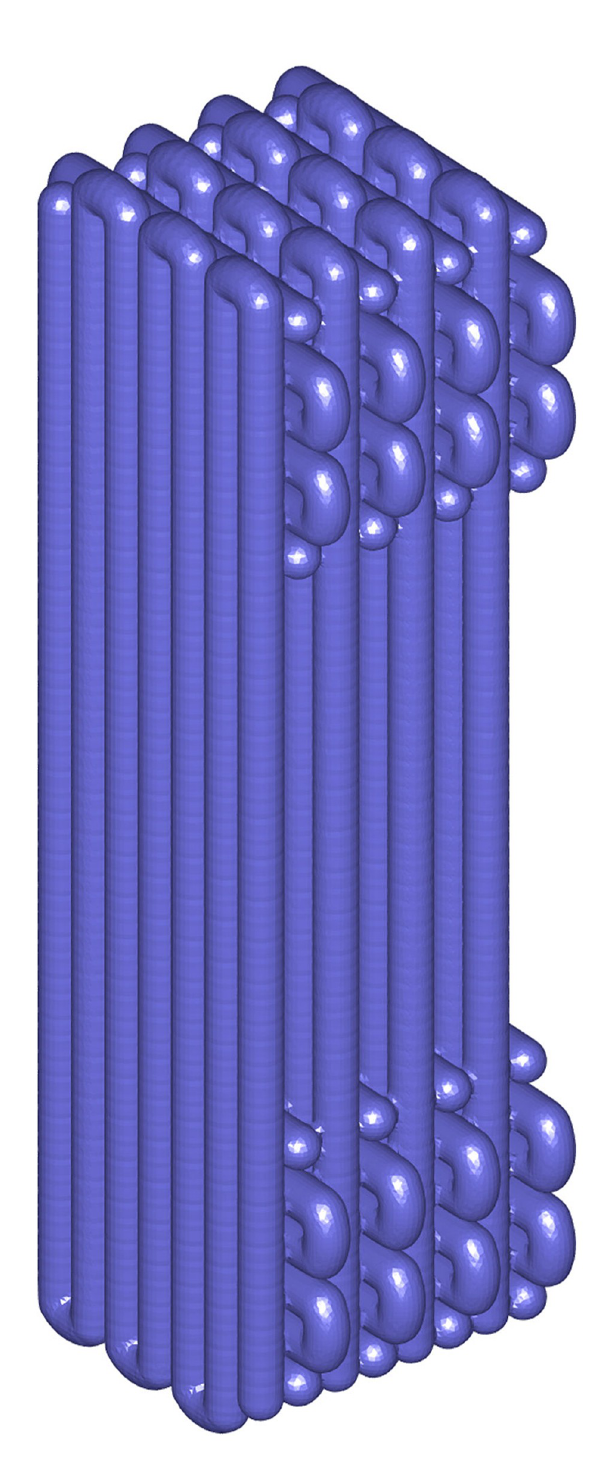
Fig 6. Geometry of rectangular sample. A 3D schematic of the rectangular sample used for uniaxial tensile and cyclic testings that consists of bone plugs and 10 mm length ligament-scaffold with 28 fibers and 350 μ m in diameter each.